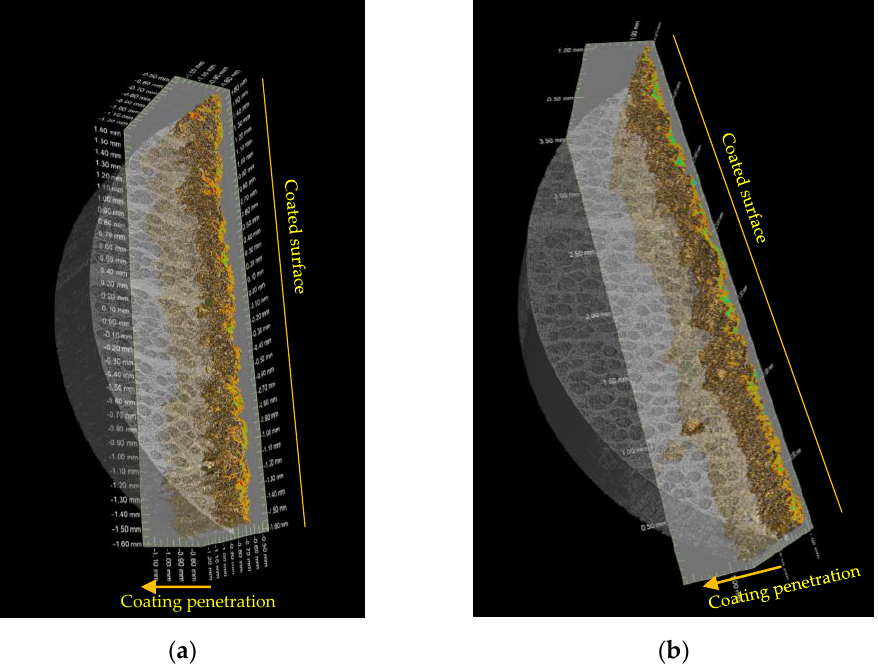
Figure 13. GL-coated veneer; ( a ) 3D visualization result using Cu target; ( b ) 3D visualization result using Mo target with Al filter.